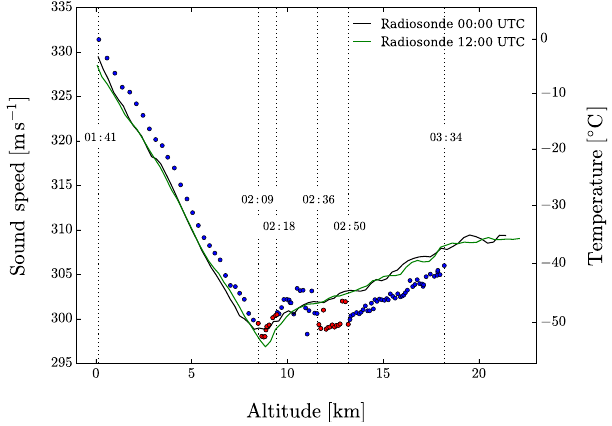
Figure 6. Plot of sounds speed versus altitude as measured by TILDAE’s sonic anemometer. The right-hand axis shows equivalent air temperature (per Eq. 3). The data shown in the plot have been averaged down to a 1min cadence. The red data points (i.e., those between 02:09 and 02:18UTC and between 02:36 and 02:50UTC) are suspect because, as described in Sect. 4.1, they may suffer from noise contamination. The solid lines show 1min medians of mea- surements from two radiosondes (see Sect. 4.2) that the AMRC launched on the same day as TILDAE at approximately 00:00 (black) and 12:00UTC